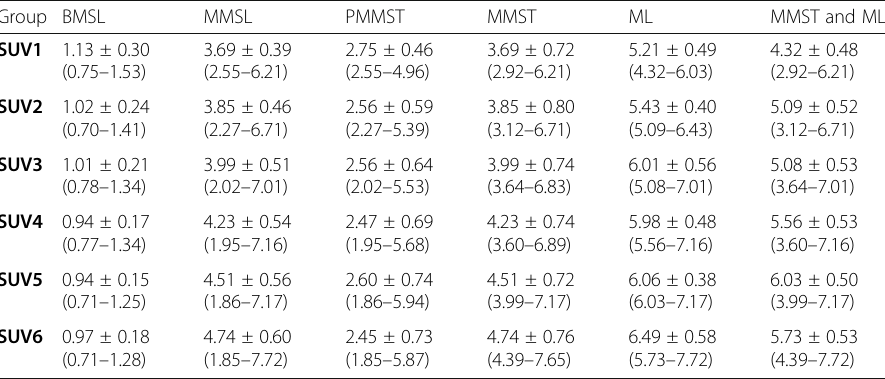
The data represent the median ± standard error of the mean; data in parentheses are the ranges SUV standardised uptake value, BMSL benign musculoskeletal lesion, MMSL malignant musculoskeletal lesion, PMMST primary malignant musculoskeletal tumour, MMST metastatic musculoskeletal tumour, ML malignant